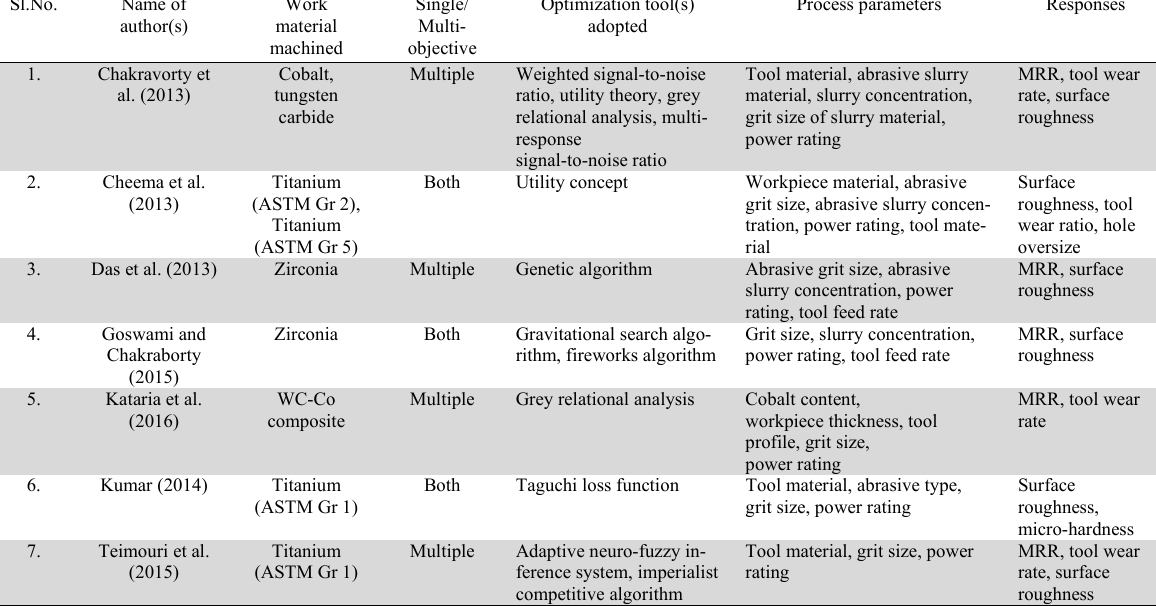
Parameters, responses, work materials and optimization techniques considered in USM processes